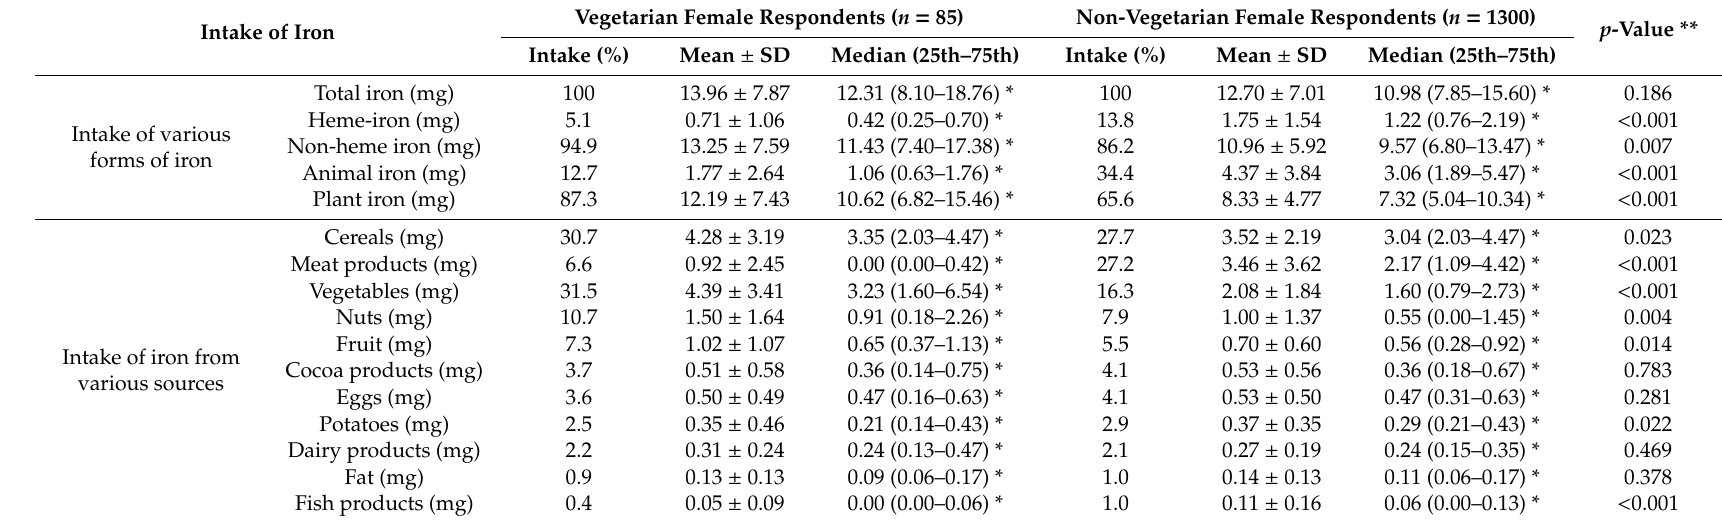
Table 6. Comparison of the intake of various forms of iron along with that of iron intake from various sources in the national sample of Polish female adolescents, in the sub-groups of vegetarian and non-vegetarian female